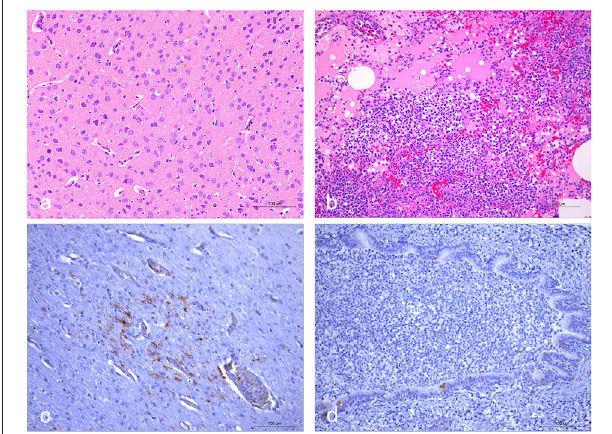
FIGURE 1 | Histopathological and immunohistochemical staining of lungs and brains of fresh dead civets. (a) Microscopic examination of brain samples showed neuronal degeneration and necrosis, perivascular edema. (b) The alveolar wall capillaries were dilated and congested, and part of the alveolar cavity was filled with abundant inflammatory exudates containing edematous fluid and lymphocytes. Moreover, lymphocytes and macrophages can be seen in the bronchus. (c) Immunohistochemical staining showed that some nerve cells in the brain tissue were positive for CDV. (d) CDV was positively detected in some bronchial epithelial cells. The scale bar indicates 100 µ m.